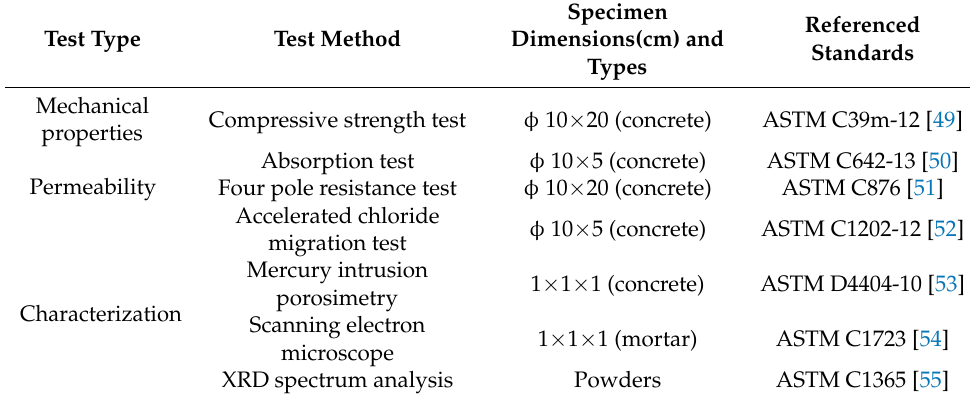
Table 13. Test items and referenced